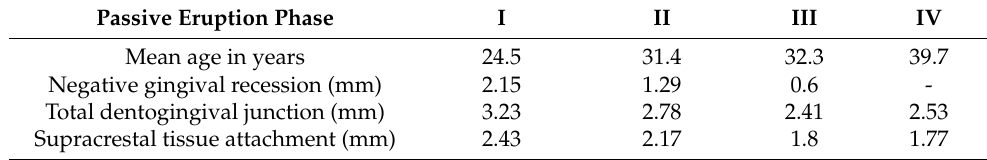
Table 1. Dimensions of dentogingival junction in 4 different stages of passive